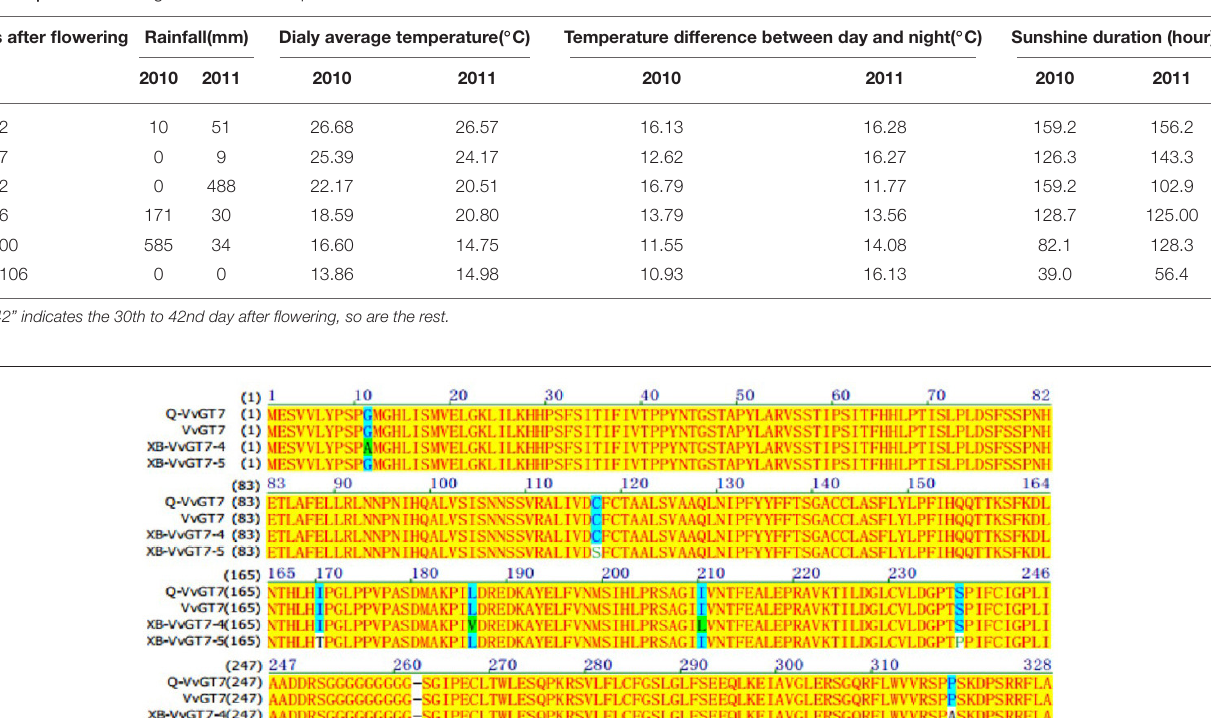
TABLE 4 | The meteorological index in the experimental site in 2010 and 2011.